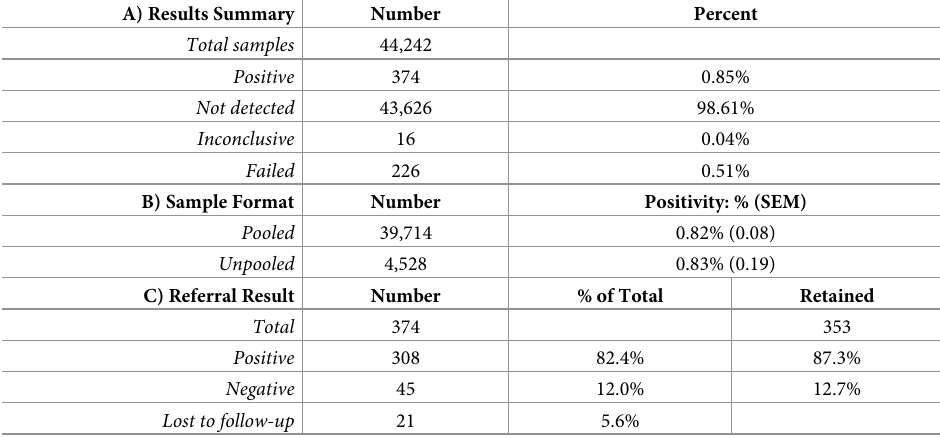
Table 2. Outcomes of surveillance testing using pooled saliva. A) Aggregate results from RT-PCR assays for all saliva samples received. B) Comparison of positivity rates for samples analyzed as pooled or individual samples. C) Results of diagnostic follow-up tests for participants referred due to positive detection of SARS-CoV-2 in